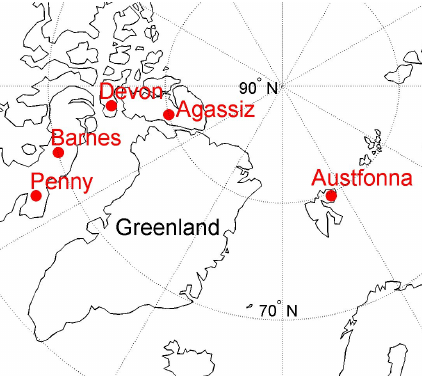
Figure 1. Location of the five ice caps measured in this